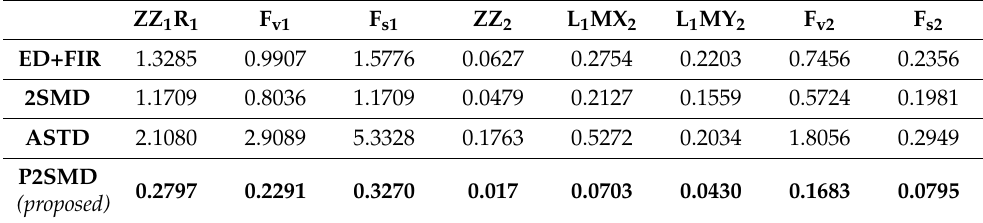
Table 3. RMS parameters errors. The lowest values are noted in